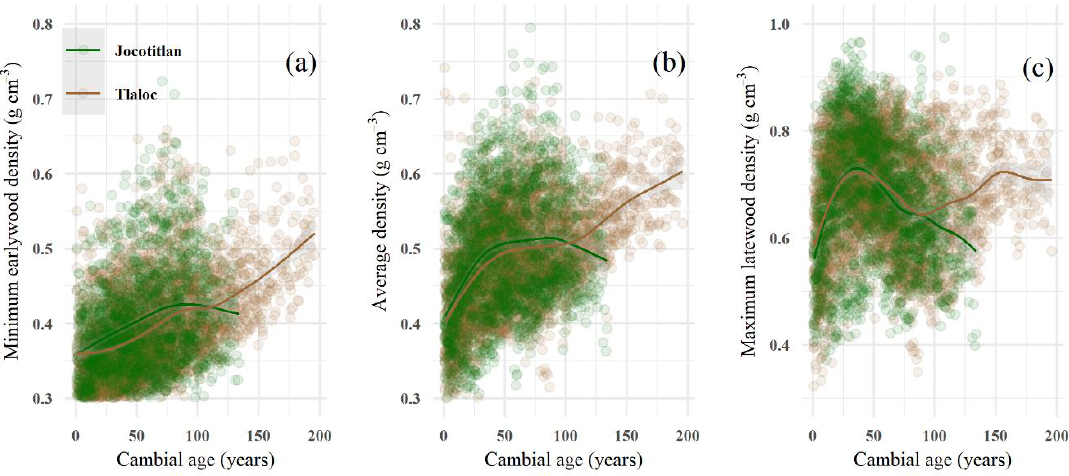
Figure 3. Cambial age effect for: ( a ) minimum earlywood density—MID, ( b ) average density—AVE and ( c ) maximum latewood density—MXD. The solid line represents a generalized additive model fit by Mountain.